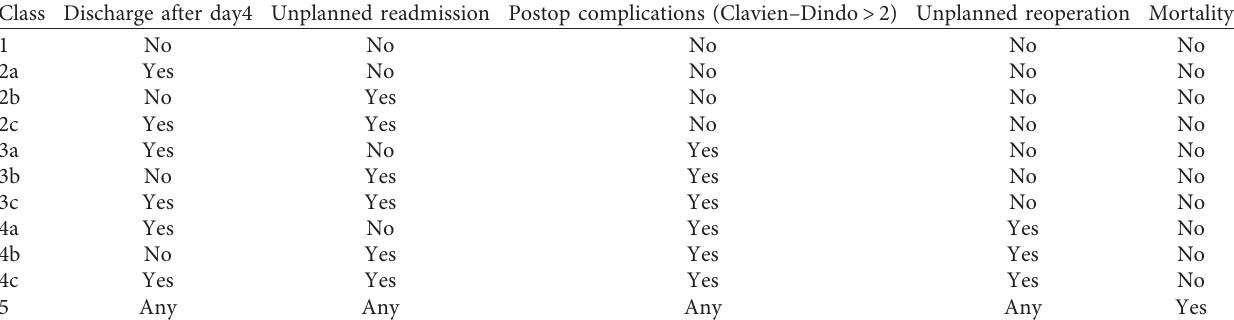
Table 1: Classification of surgical outcomes after colorectal